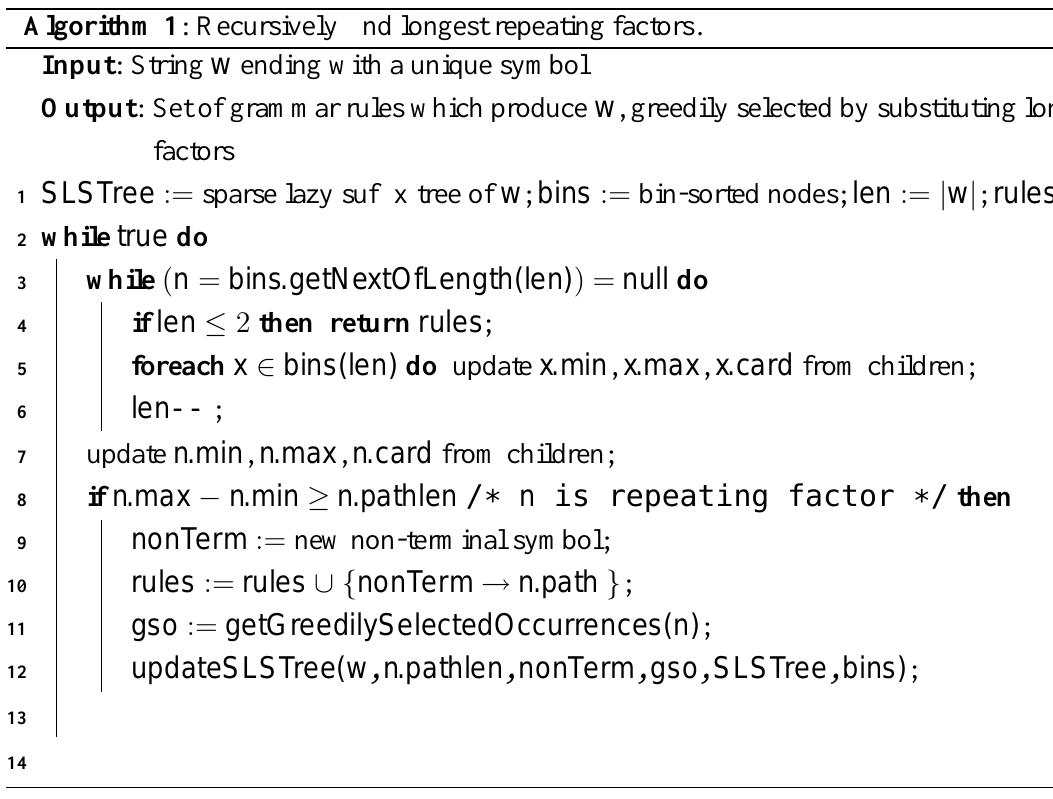
Algorithm 1 : Recursively find longest repeating factors.